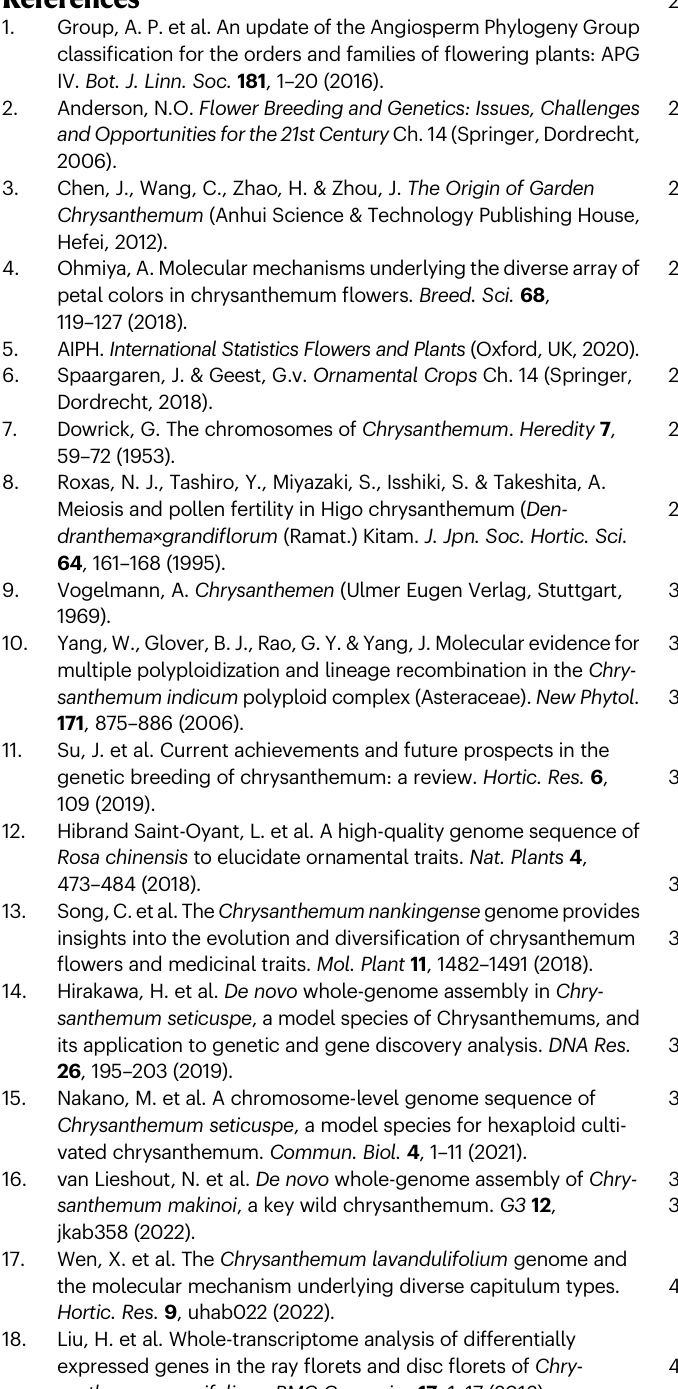
Figshare [https://doi.org/10.6084/m9. fi gshare.21655364.v2]. The Ara- bidopsis ABCE and chrysanthemum CYC2 genes were used as query sequences for gene family identi fi cation, which are available at Fig- share[https://doi.org/10.6084/m9. fi gshare.21610305].Sourcedataare provided with this